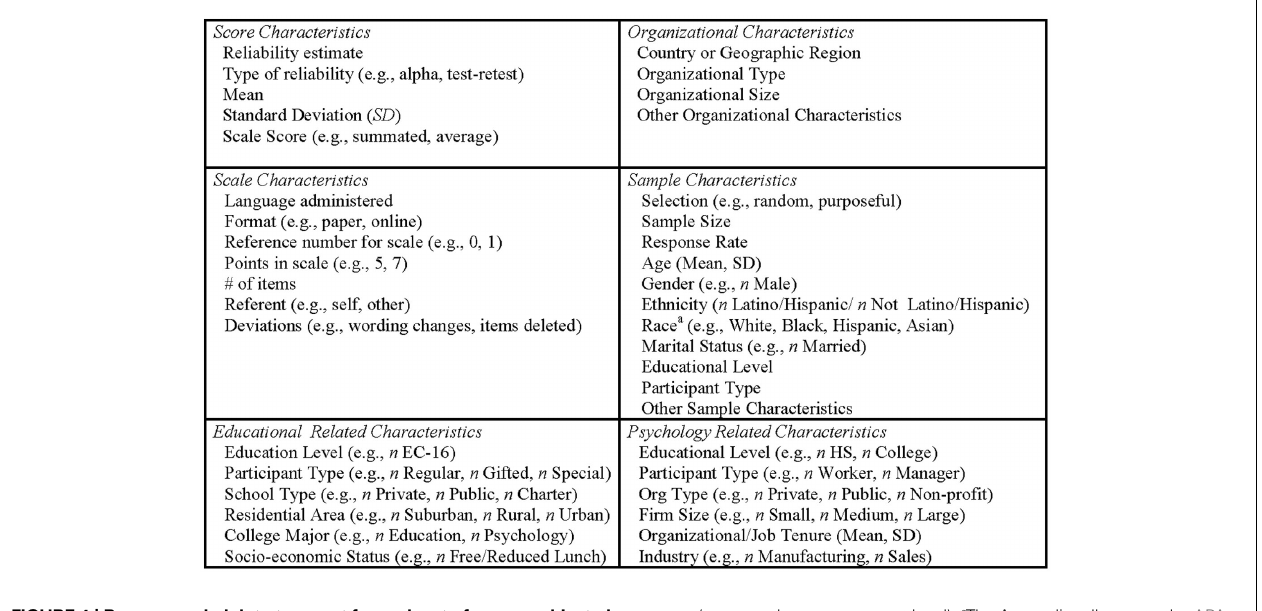
FIGURE 4 | Recommended data to report for each set of scores subjected to an inferential test. Note: Data should be reported for each set of scores analyzed across all measurement occasions (e.g., pre-test, post-test) and